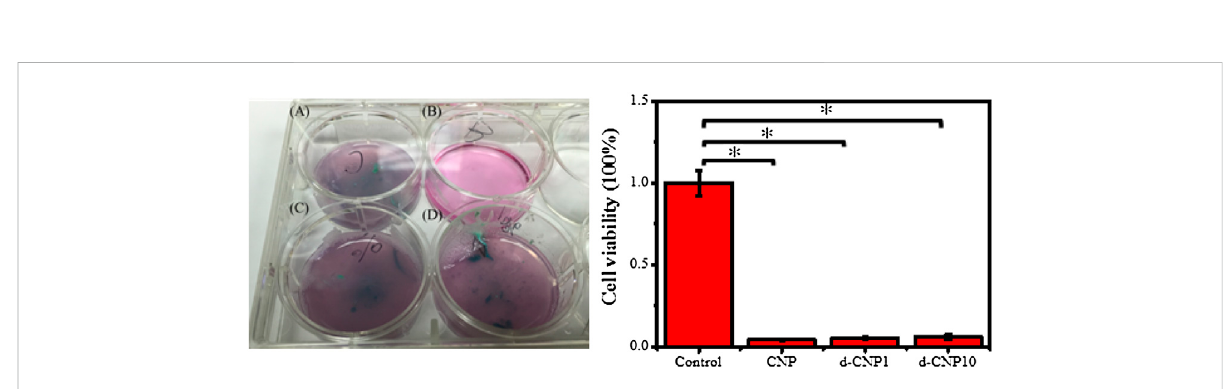
(Left)Images ofpre-attachedelectroactive cellsona6-wellcultureplateafter 1 hofelectrical stimulation. (A) CNP, (B) control, (C) d-CNP1and (D) d-CNP10. (Right) The statistical cell viability for the electroactive cells after electrical stimulation. (n = 6, ρ <